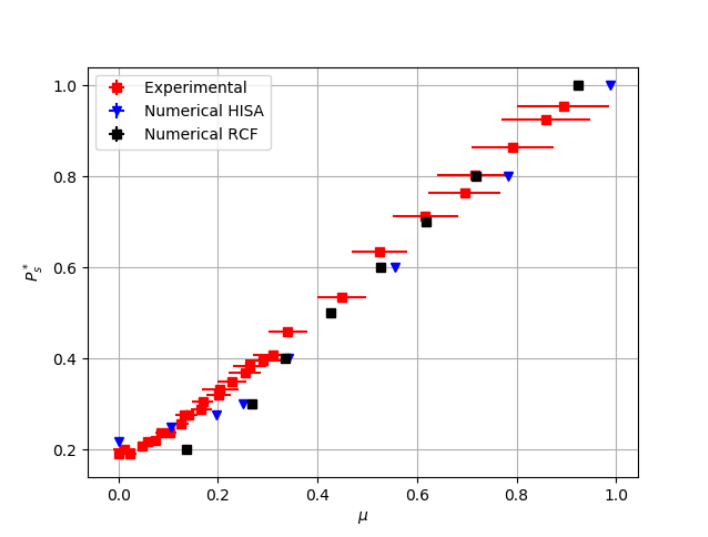
Figure 10. Results from both solvers versus experimental